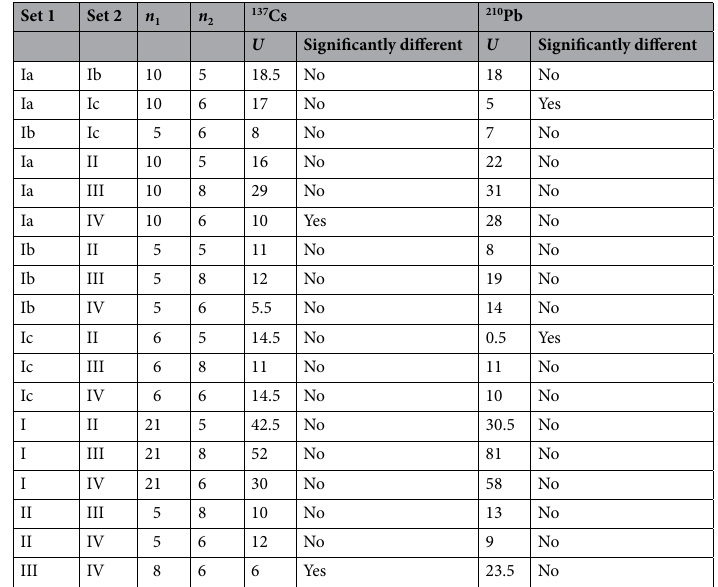
Table 3. Summary of the results of the application of the Mann–Whitney test, two-tailed, to sets of data in Tables 1 and 2. The sizes of the compared sets are n 1 and n 2 , and the significance level is α =